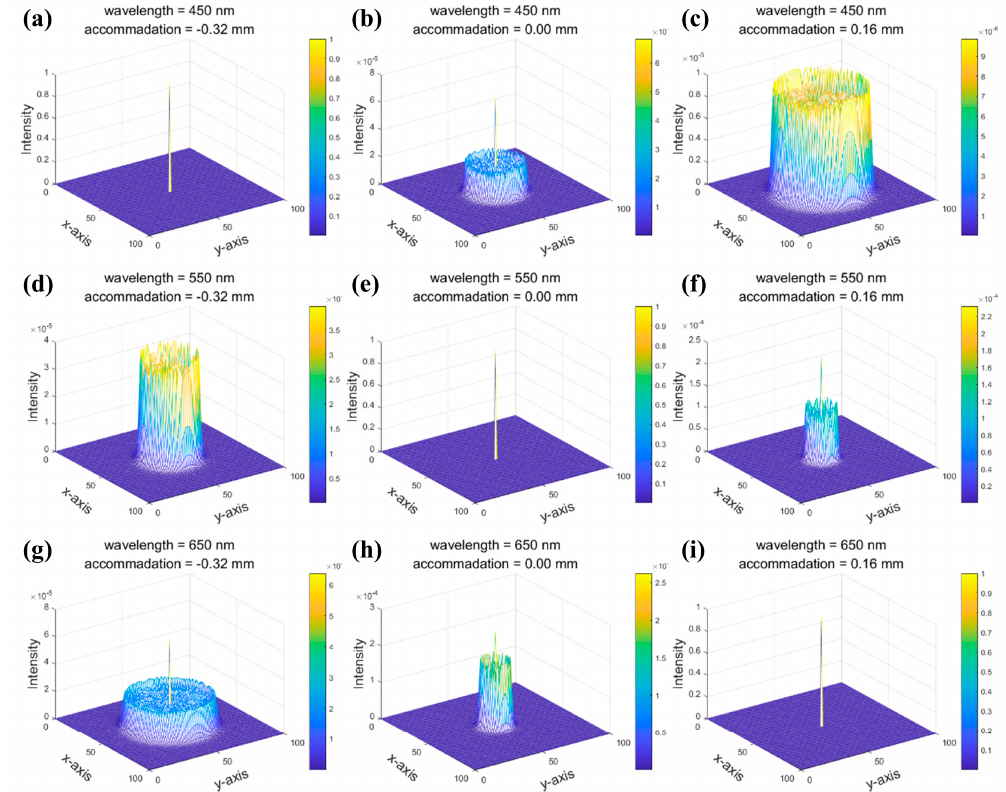
Figure 2. The point spread function (PSF) simulations. ( a – c ) The PSFs at a wavelength of 450 nm, where the beam wavelengths of 450 nm, 550 nm, and 650 nm focused on the detection plane, corresponding to focal length shifts f at − 0.32 mm, 0 mm, and 0.16 mm, respectively. ( d – f ) The PSFs at a wavelength of 550 nm, where the detection plane positions are the same as above. ( g – i ) The PSFs at a wavelength of 650 nm, where detection plane positions are the same as above.